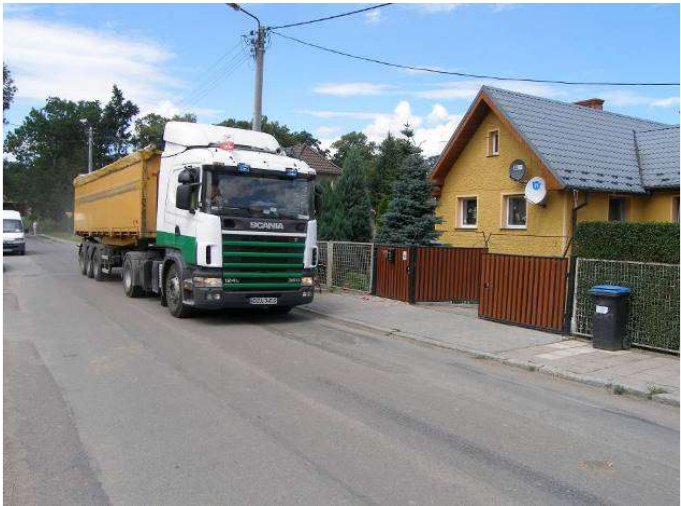
Figure 1. The analyzed building during measurement of vibrations.